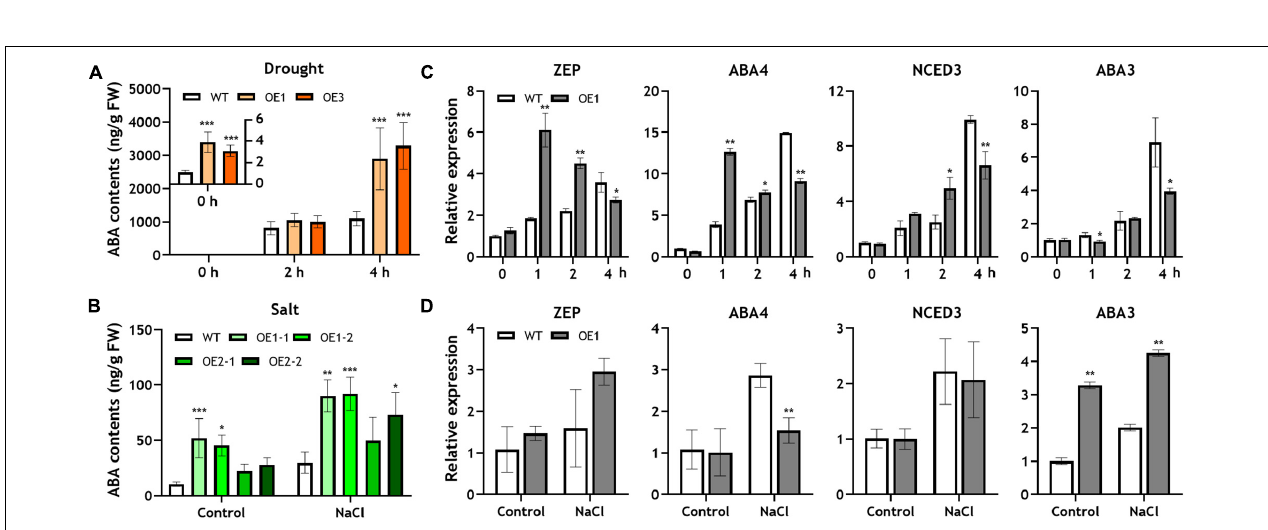
FIGURE 2 | Endogenous ABA concentration and expression of ABA biosynthetic genes in the OsRF1 -OE plant under drought and salt stress. (A,B) Endogenous ABA contents in WT and OsRF1 -OE rice under drought and salt stress conditions. The ABA content in shoots was measured by TSQ LC/MS/MS. Data represent mean ( ± SD) from three independent experiments with two biological replicates ( n = 3). (C,D) qRT-PCR analysis of ABA biosynthetic genes in the OsRF1 -OE plant under salt and drought stress. The relative expression levels of ABA-related genes in shoots of stressed or non-stressed wild-type and OsRF1 -OE were indicated as bar graph. The expression levels of each gene were normalized with expression levels of the internal control gene, Ubiquitin,5 and analyzed with the (cid:49)(cid:49) Ct method. ZEP , zeaxanthin epoxidase; NCED , 9- cis -epoxycarotenoid dioxygenase; ABA3 , molybdenum cofactor (MoCo) sulfurase. Data represent mean ( ± SD) from three independent experiments with three biological replicates ( n = 3). All statistical analyses for data were performed by Student’s t -test. * P < 0.05; ** P < 0.01; *** P < 0.005.